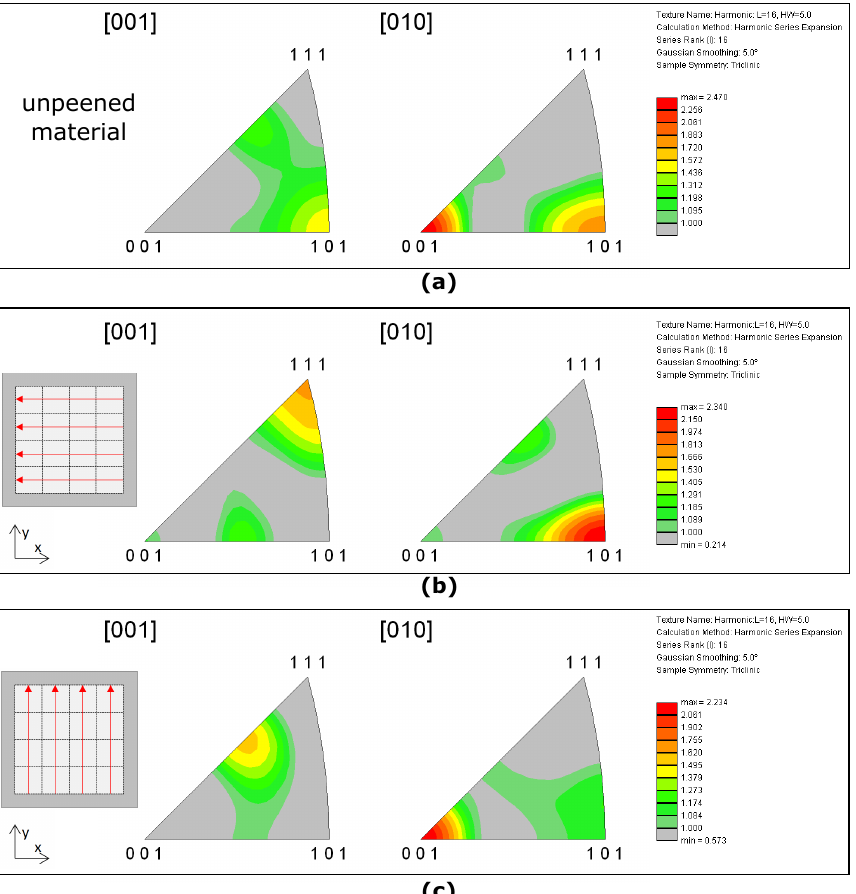
Figure 6. Electron backscattered diffraction (EBSD) micrographs of unpeened AA2024-T3clad: the TD-direction is defined as the direction of the material’s thickness ([010]), and RD-direction is defined as the rolling direction ([100]).